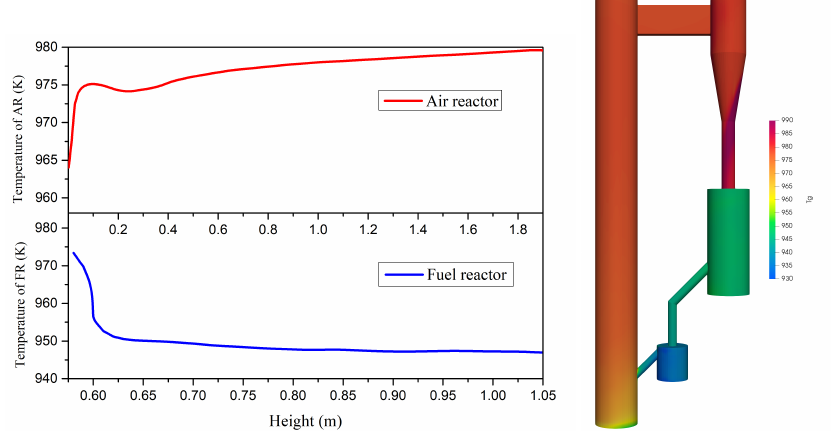
Figure 6. Distribution of temperature in the CLC system. Left : Profile of time-averaged temperature in AR and FR. Right : Plot of gas phase temperature in the system.